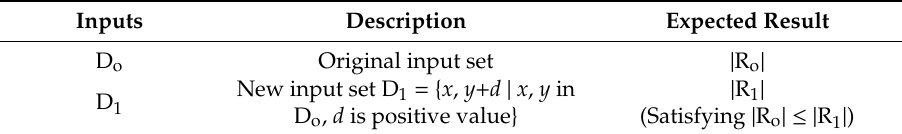
Table 4. Test inputs for stopping at the stop line.